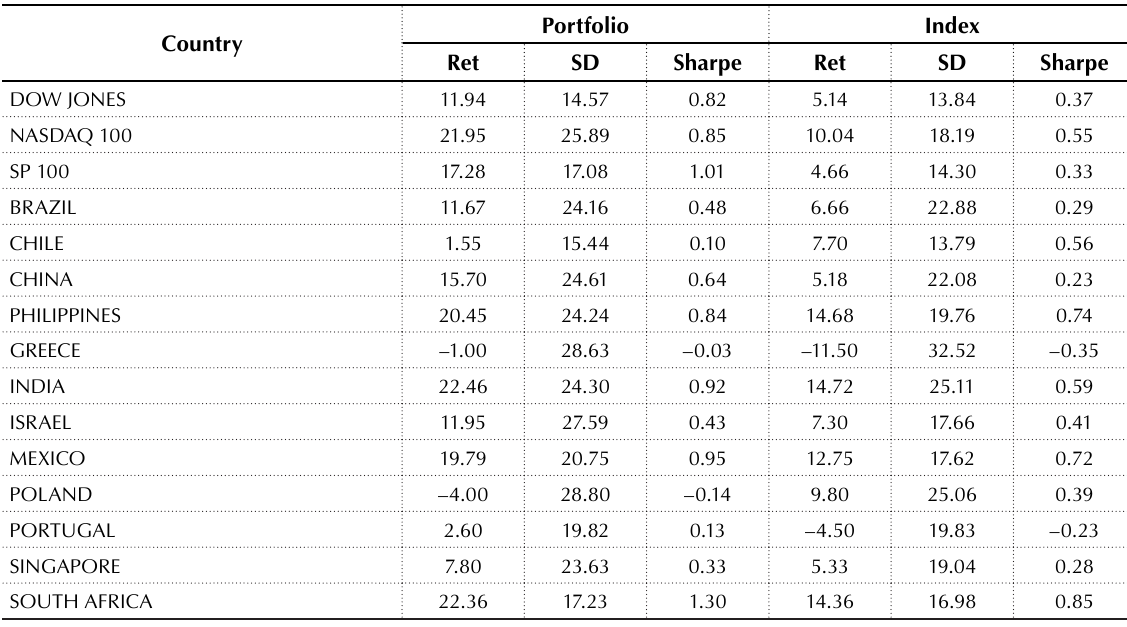
Table 8. Performance of restricted mean-variance optimized portfolios, excess returns Panel A. Performance